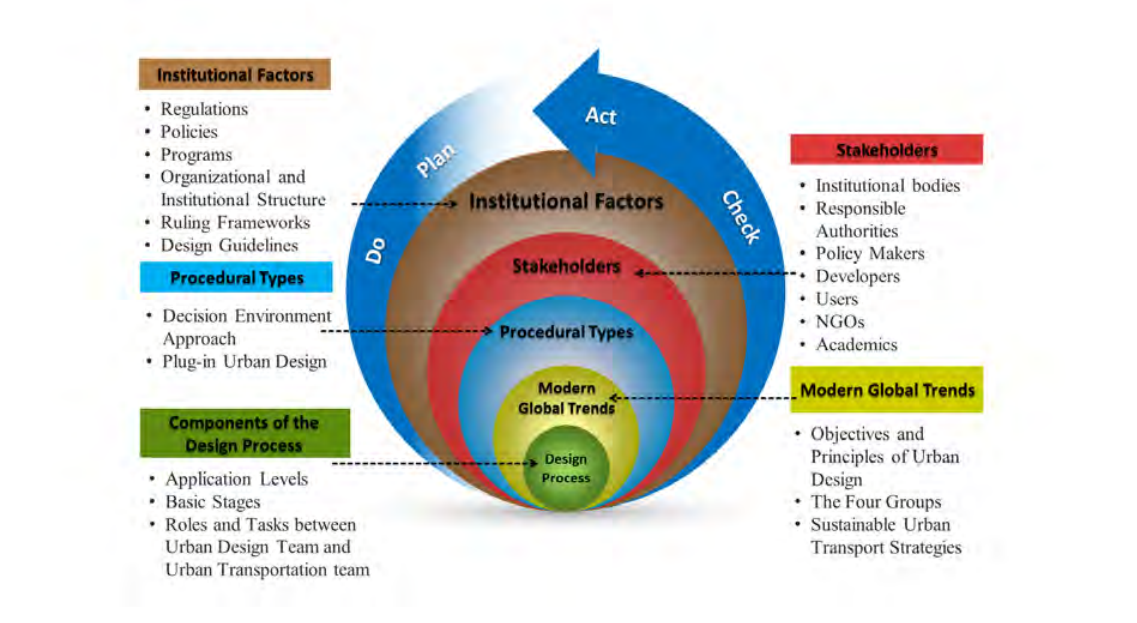
Figure 2. General Combined Framework of the Urban Design and Urban Transportation Design Processes. Source: (Mohammed, 2016, p.